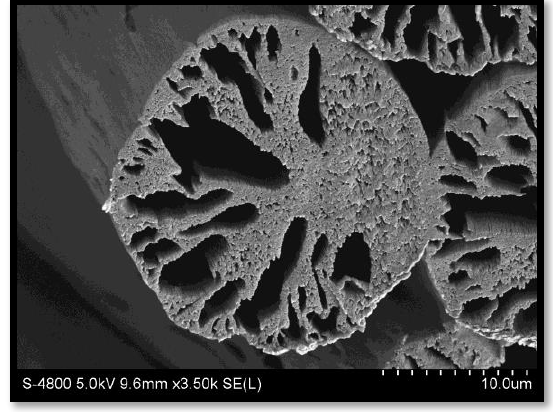
Figure 1. Example of a polyacrylonitrile (PAN) fiber spun at high coagulation bath temperature (60 °C), containing